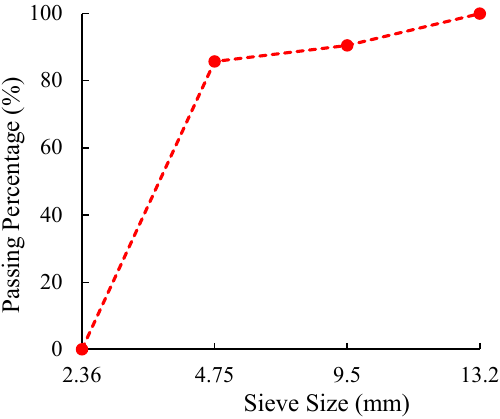
Figure 2. Aggregate gradation of synchronous macadam.